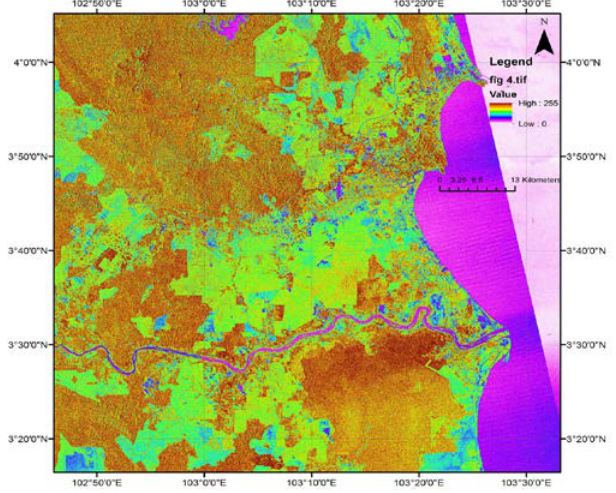
Figure 4. Image map of Pahang estuary extracted from PALSAR HV polarization